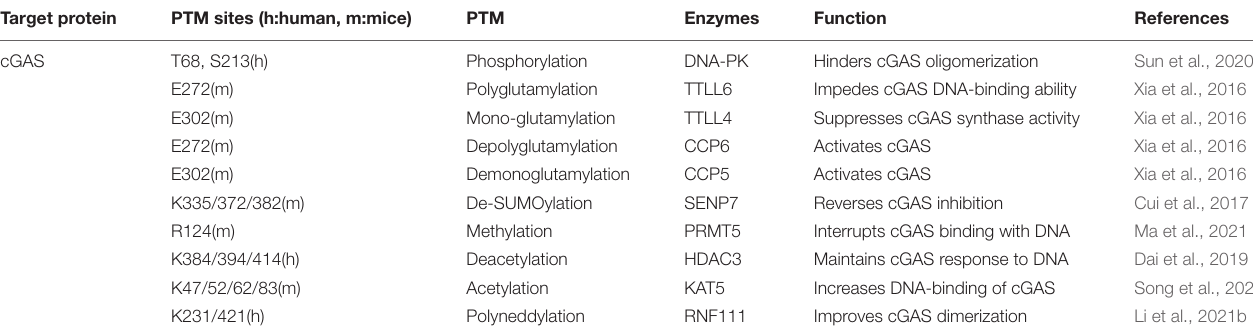
TABLE 1 | Enzymes involved in cGAS